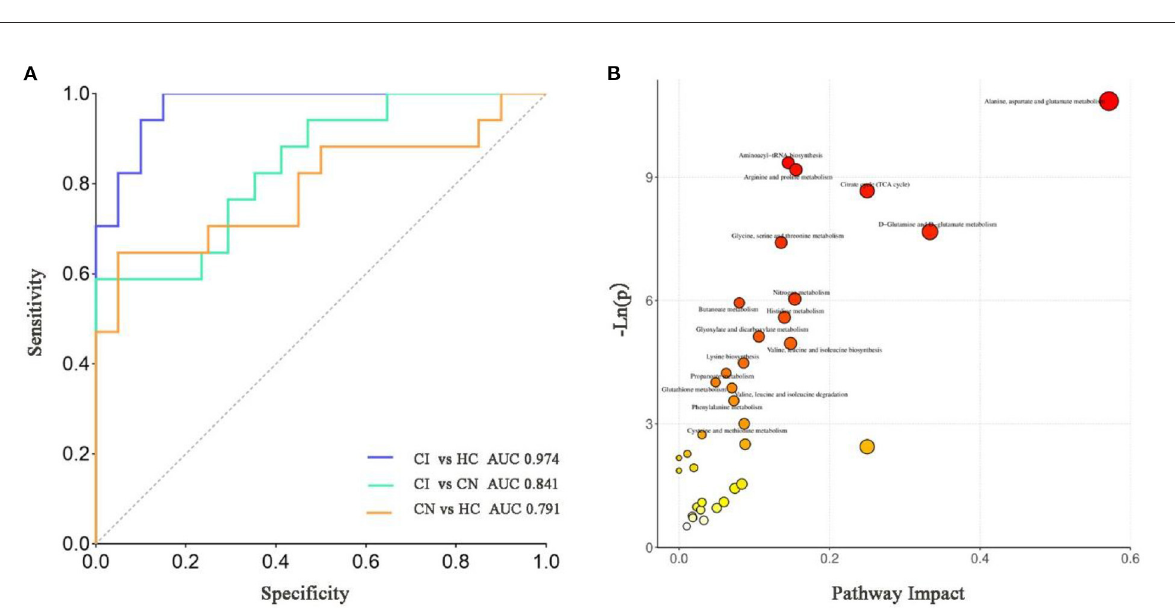
FIGURE4 (A) The ROC diagnostic analysis of biomarker panel (Imidazolepropionic acid, Erythronic acid, Homoserine, and Aspartic acid) for different groups. (B) Pathway analysis bubble plot by the Hsa set in KEGG. The x-axis is the pathway impact, indicating the importance of differentially expressed metabolites in metabolic pathways. The y-axis is the negative logarithm of p -value. The size of pathway symbols represents the statistical significance level of pathway analysis. The color of pathway symbols represents the impact factor. Large sizes and dark colors represent central pathway enrichment and high pathway impact values,